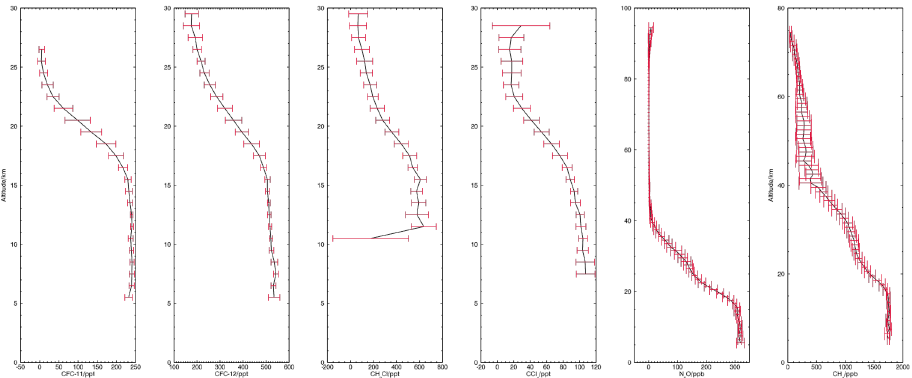
Figure C9 The mean vertical profile of CFC-11, CFC-12, CH3Cl, CH4 & N2O, calculated using data from 2009 between 30° and 45° South Fig. C10. The mean vertical profile of CFC-11, CFC-12, CH 3 Cl, CCl 4 , N 2 O and CH 4 , calculated using data from 2009 between 30 ◦ and 45 ◦